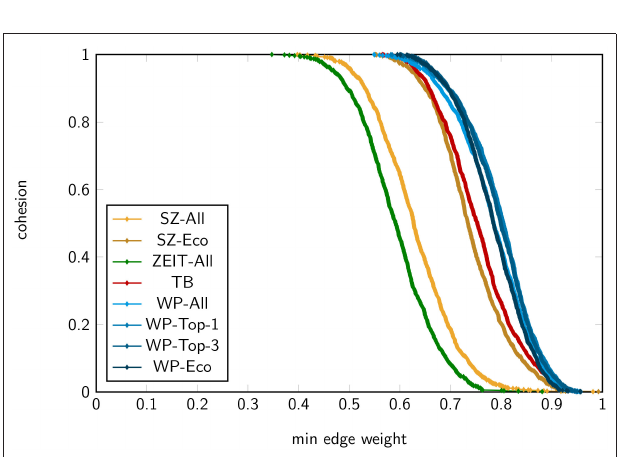
FIGURE 8 | Network cohesion as a function of the minimum weight per α -cut of word embedding networks of threshold concepts according to the skip-gram